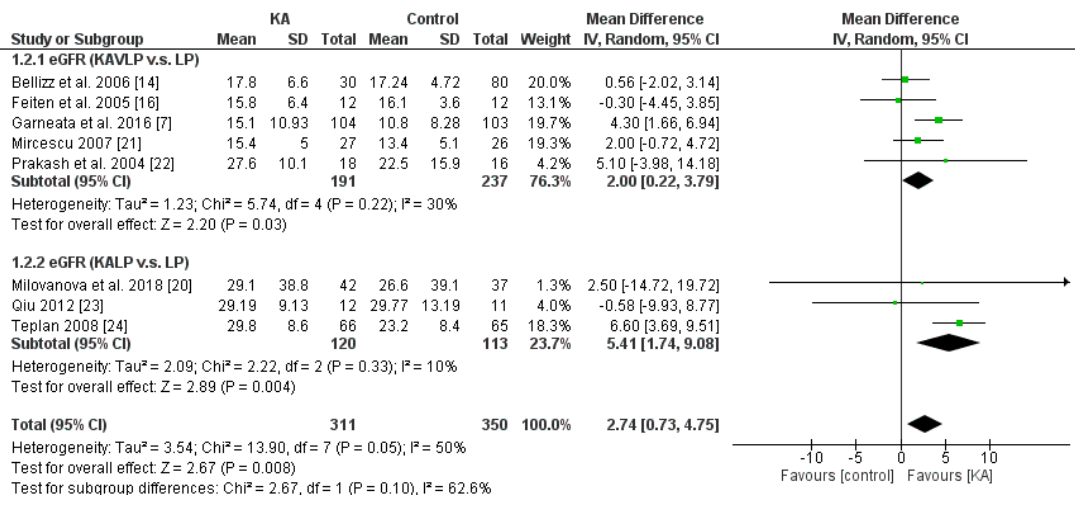
Figure 2. Forest plot of effects of ketoanalogues (KA) on estimated glomerular filtration rate (eGFR) in chronic kidney disease (CKD) patients, based on the random-effects model.